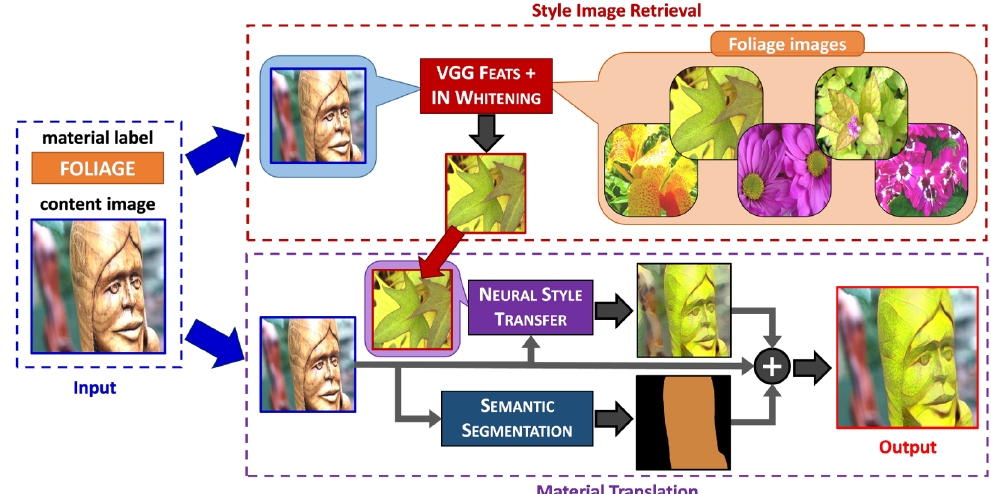
Figure 4. General overview of our proposal for material translation using style image